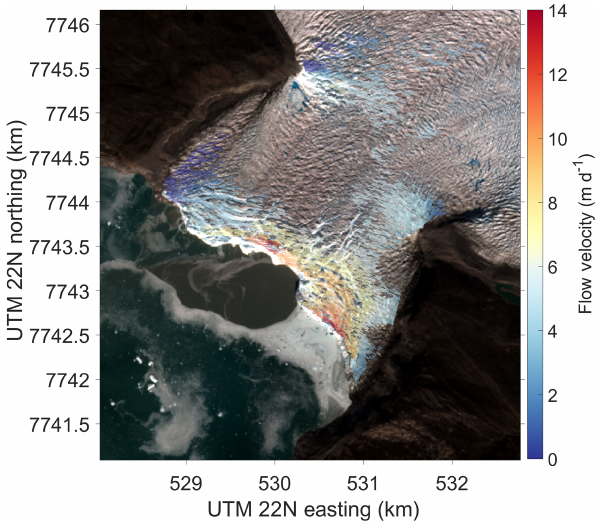
Figure 8. Flow speed map based on 4d integrated TRI acquisitions between 21 and 25 August 2016. The shown flow speeds represent the flow magnitude in line-of-sight direction towards the TRI sen- sor (see Fig. 1). No velocities could be derived for areas shadowed by the glacier’s topography. Values with a coherence < 0 . 6 or out- side the glacier tongue were masked out. Clearly visible are the rifts close to the glacier’s tongue, showing jumps in the glacier flow speed. Background: Sentinel-2A scene from 3 August 2016. This figure contains Copernicus Sentinel data